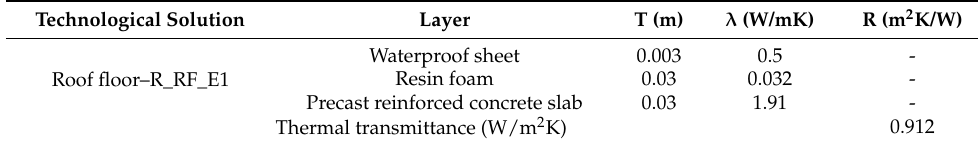
Table A19. Existing roof floor stratigraphy (R_RF_E1).